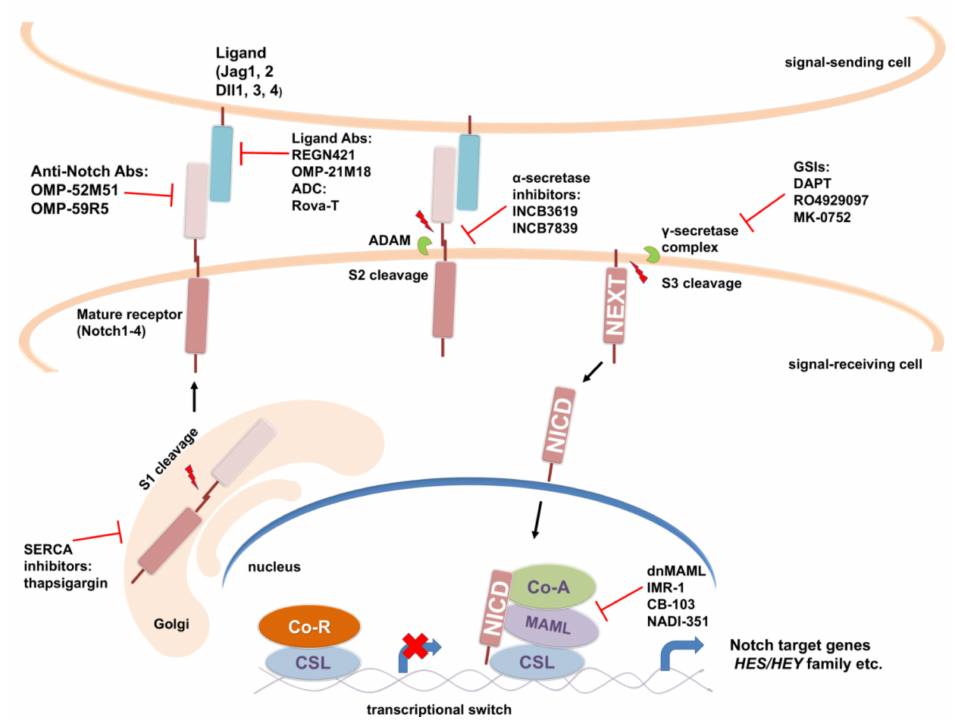
Figure 4. Scheme of a canonical Notch signaling pathway and therapeutic targets. During transport through endoplasmic reticulum and Golgi apparatus, Notch precursor is glycosylated, cleaved into a heterodimer (S1 cleavage) and transported to the cell membrane. Binding with Notch ligand induces second cleavage (S2 cleavage) by a member of ADAM family of proteases, leaving membrane-bound Notch extracellular truncation (NEXT) fragment. NEXT is subsequently cleaved by γ -secretase complex (S3 cleavage) releasing the active form of the Notch receptor, Notch intracellular domain (NICD), which can translocate to the nucleus, where it activates transcription of Notch target genes by forming transcriptional complex with DNA-binding protein CSL (also known as CBF1/in mammals, Suppressor of Hairless in Drosophila , and LAG-1 in C. elegans ) and MAML, which further recruits other transcriptional coactivators (Co-A). Classes of inhibitors and antibodies (Abs, ADC) that target Notch pathway components are indicated. References are included in the main